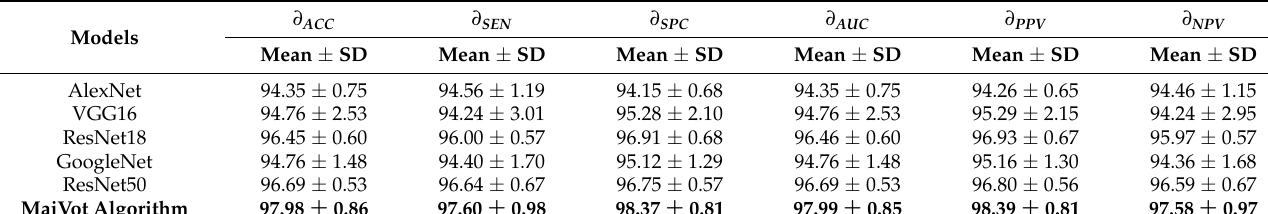
Table 7. Five-fold test performance of T2W-MRI Data.